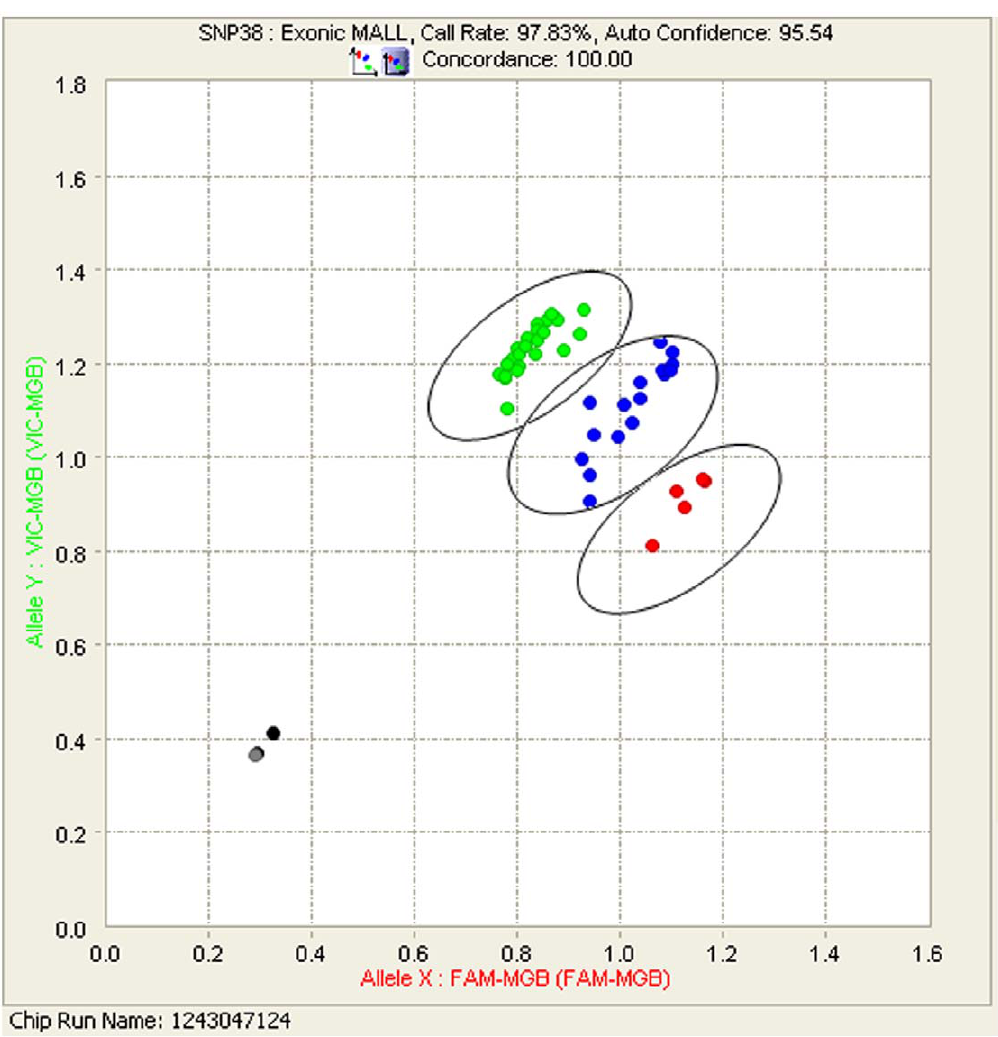
Figure 4. Scatter plots showing genotype call clusters for 46 whale samples using one assay (Exonic MALL). The groups ( pp -‘ red ’, qq - ‘ green ’ and pq ‘ blue ’) are denoted in